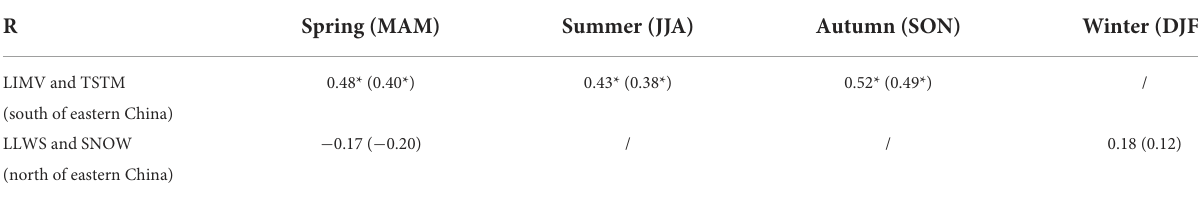
TABLE 2 Correlation coefficients of average frequency between different hazards at airports over southern or northern